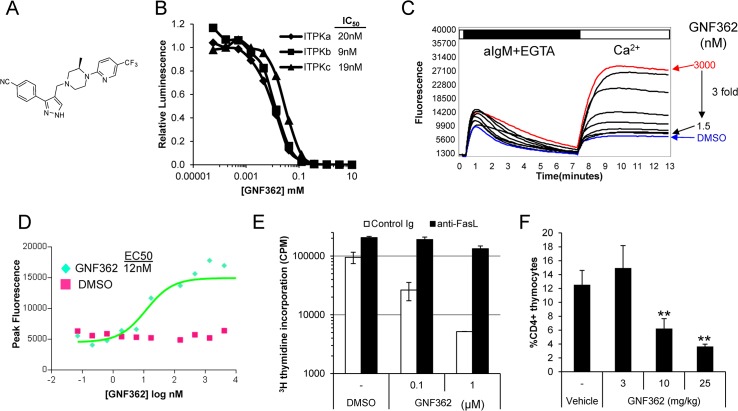
Identification and characterization of Itpkb inhibitors.(A) GNF362 was identified following a 2 million compound biochemical screen, co-crystallography with Itkpb, and additional medicinal chemistry optimization. (B) The biochemical activity of GNF362 was determined in Kinase Glo assays using purified Itpka, Itpkb, and Itpkc proteins [14]. Data shown is one representative experiment. (C) The cellular activity of GNF362 was profiled on wild type B cells loaded with the calcium-sensitive dye, Fluo-4. Splenocytes were pre-incubated with varying concentrations of GNF362, and SOC-mediated Ca2+ entry, depicted as the mean value of Fluo-4 over time, was measured on the FLIPR following stimulation with anti-IgM and calcium add-back. (D) The peak calcium response, after calcium re-addition is shown as a function of the concentration of GNF362 in the assay, with an EC50 of 12nM. Data shown is one representative experiment. (E) Purified CD4+ T cells were stimulated in the presence of GNF362, along with the addition of either anti-FasL or a control Ig, to determine the effect on proliferation and FasL-mediated activation-induced cell death. Data shown is representative of three independent experiments. (F) Wild type mice were dosed orally with GNF362 at 3, 10, or 25mg/kg twice daily for 9 days. The percentage of CD4+ T cells in the thymus was determined by FACS analysis. Data shown is representative of three independent experiments. **, P < 0.01.